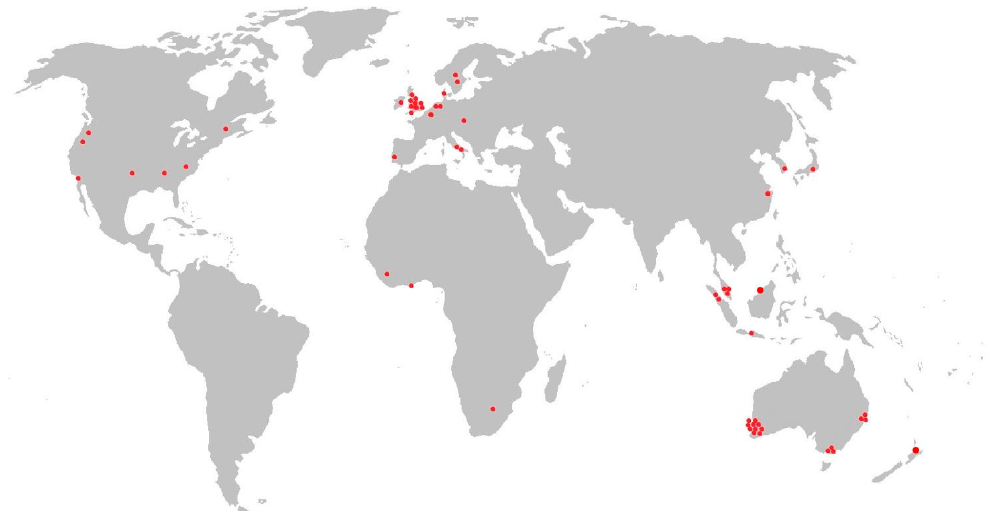
Figure 5. Distribution of research effort into the links between urban livability and PGI identified by the initial search. Markers are placed for all cites specifically mentioned in articles. A marker was not placed for studies where research location was not reported or for articles with a global focus (i.e., editorial or review style articles).